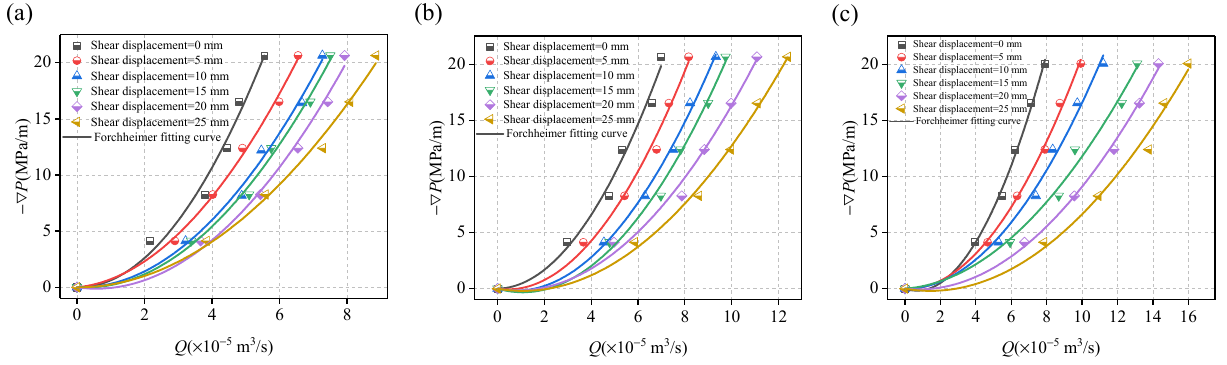
Figure 5. Relationship between the hydraulic gradient ( − ▽ P ) and flow ( Q ) in the structural plane at fluctuation angles of ( a ) 15 ◦ , ( b ) 30 ◦ , and ( c ) 45 ◦ . Table 2. Fitting results associated with the Forchheimer equation for the hydraulic gradient and discharge of the regular tooth-shaped structural plane.